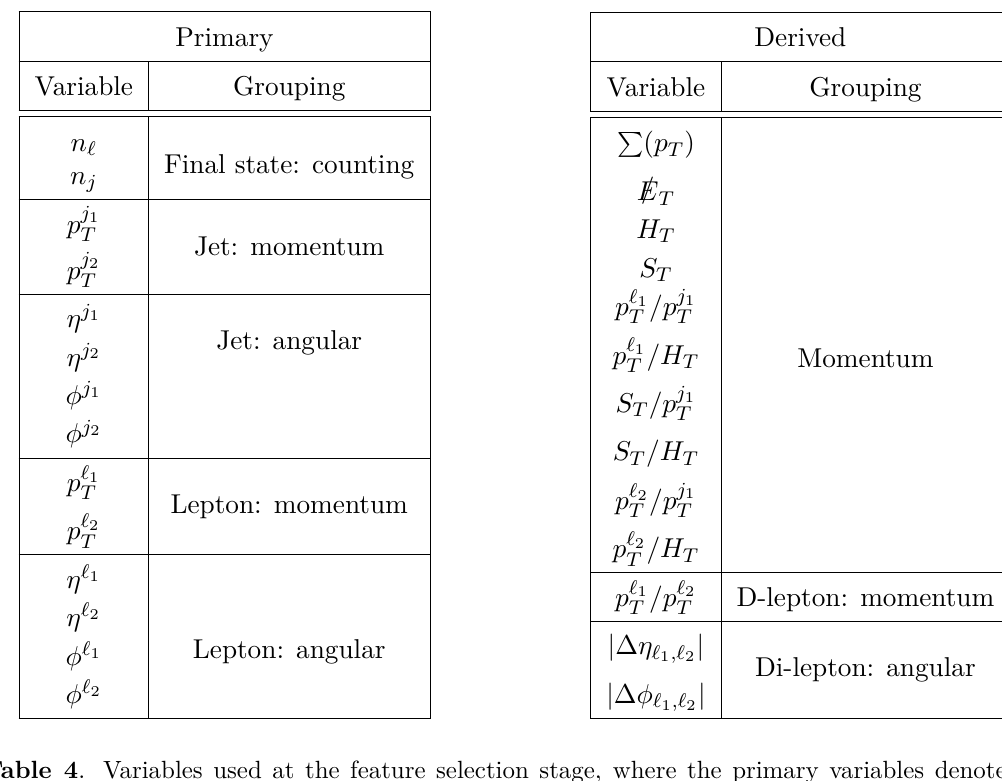
Table 4 . Variables used at the feature selection stage, where the primary variables denote low level variables taken directly from simulators, and derived variables are higher level and require manipulation. The final 5 derived variables are only considered if there are at least two leptons in the event ( n ‘ ≥ 2